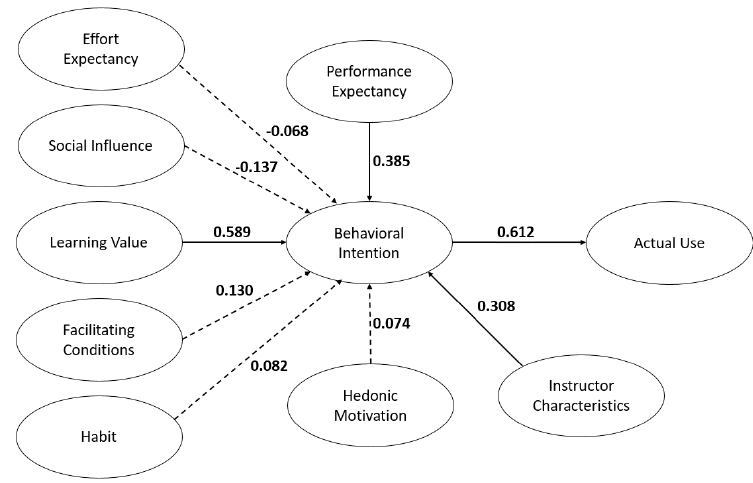
Figure 2. The initial model. Table 2. Model modification.